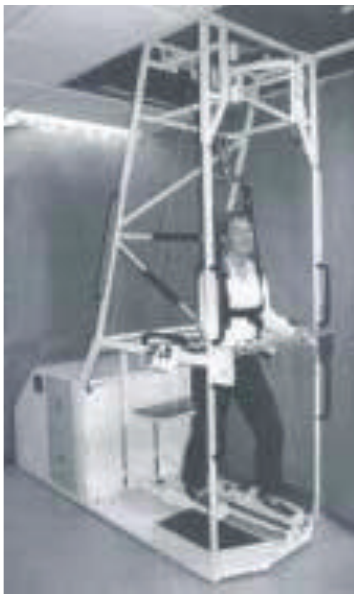
Figure 3: Gait Trainer.